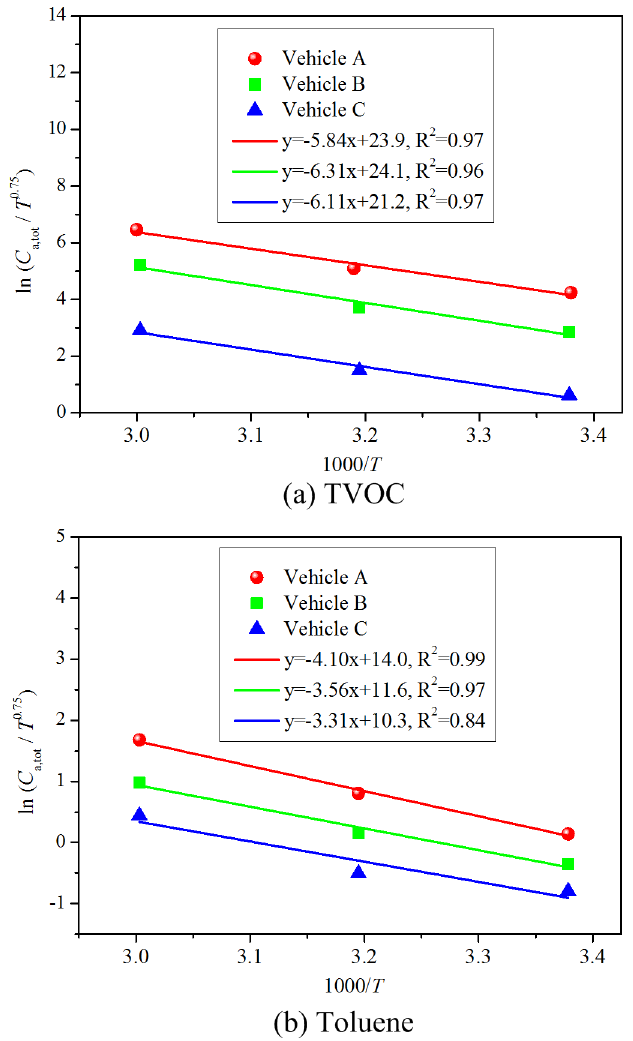
Fig 7. Validation of correlation (16) with You et al. ’ s [28] experimental data from vehicular environments.